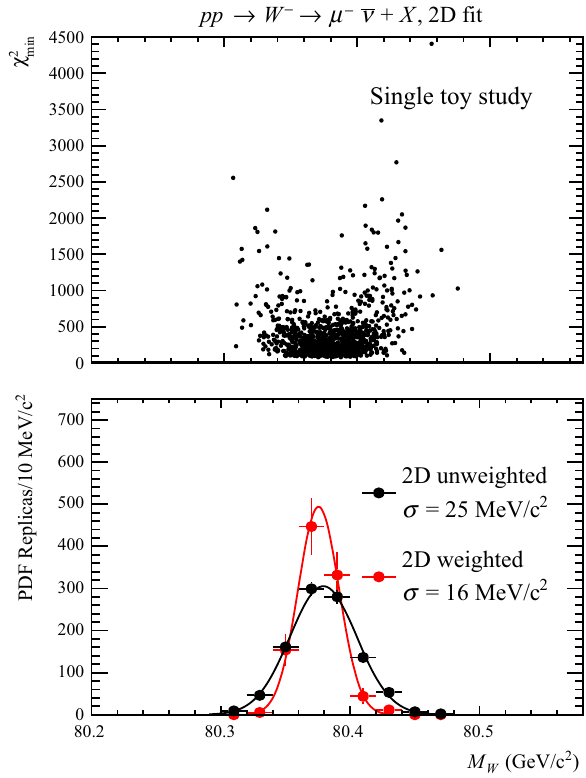
Fig. 9 Upper: the distribution of the χ 2 versus M W for a two- dimensional fit to a single toy dataset, which assumes the LHCb Run 2 statistics, with each of the 1000 NNPDF3.1 replicas. Lower: the distri-